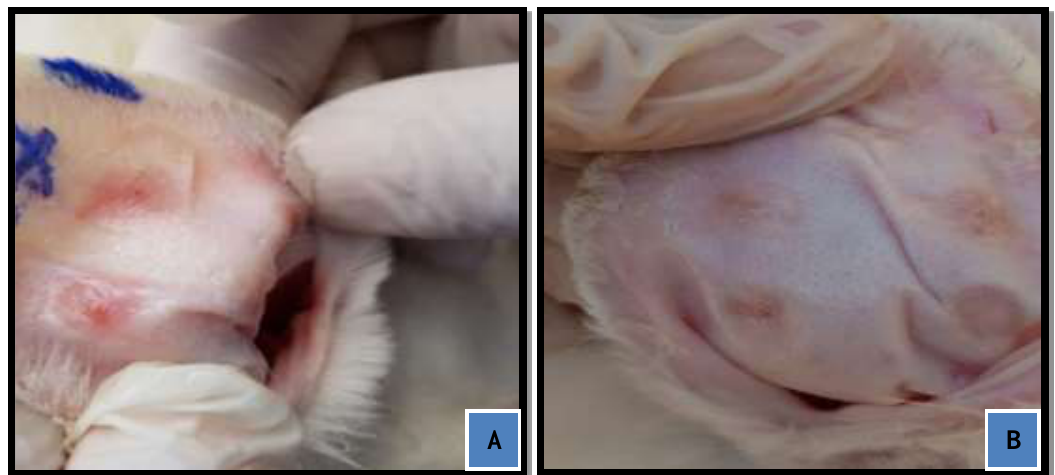
Figure 3. Treatment with Ritodrine (G4).A. Application of topical gel on induced model B. After 21 days of treatment